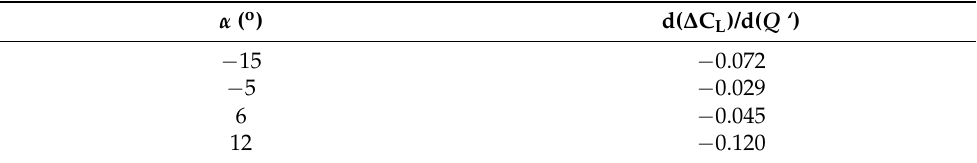
Table 2. Summary of the decay rates of ∆ C L against the Q ‘ at four representative α .